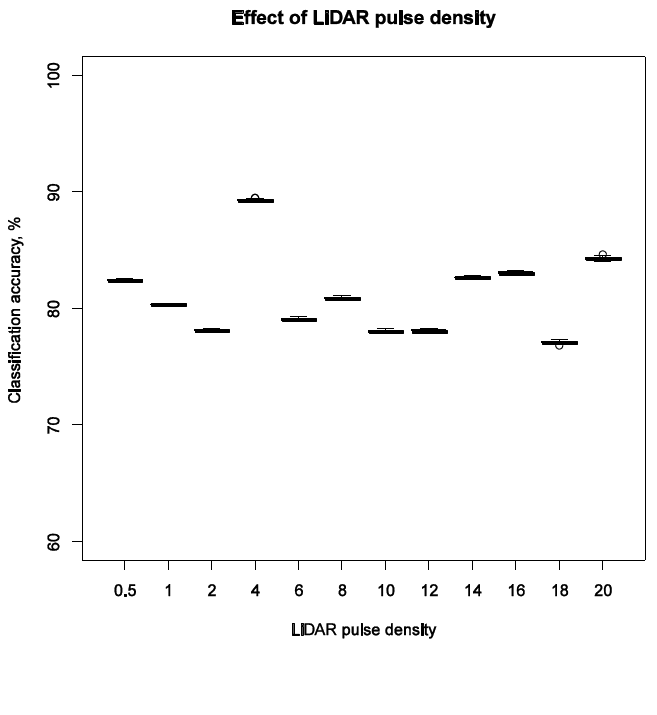
Figure 3. Effect of pulse density to the accuracy of area-based mapping of